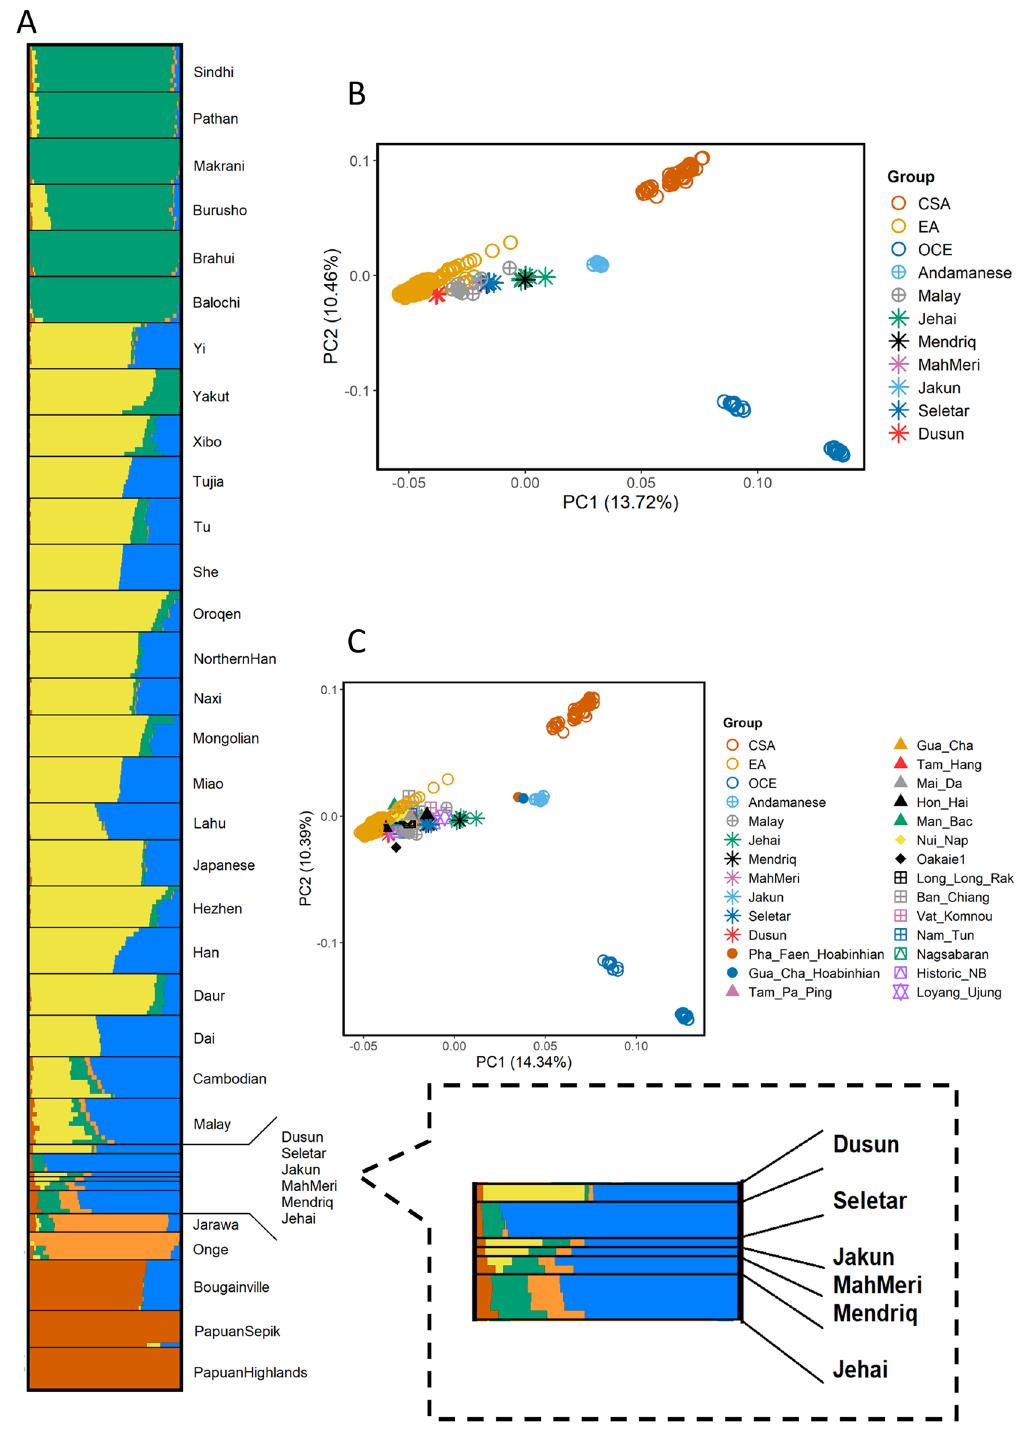
Figure 1. PCA and ADMIXTURE analysis. ( A ) ADMIXTURE analysis results at K = 5 of indigenous Malaysians, Andamanese, Malay, and selected HGDP-CEPH population samplesshowes that the ancestral component related to Southeast Asia (blue) is the most pronounced in OAs while ancestral components related to East Asia (yellow) and South Asia (green) are also present in most of OA groups. ( B ) Global PCA with indigenous Malaysian populations, Andamanese, Malay and selected HGDP-CEPH samples showes that OAs are in general genetically closer to East Asians while Malaysian Negritos have tendency towards Andaman islanders. ( C ) PCA representing ancient Southeast Asian with indigenous Malaysian, Andamanese, Malay and HGDP-CEPH populations from East Asia (EA), Central South Asia (CSA) and Oceania (OCE). Most of OAs positioned between Hoabinhian hunter-gatheres and ancient farmers. Plots are generated using ggplot2 version 3.3.3 package (https:// ggplo t2. tidyv erse. org/) in R version 4.0.4 (https:// www.R- proje ct.